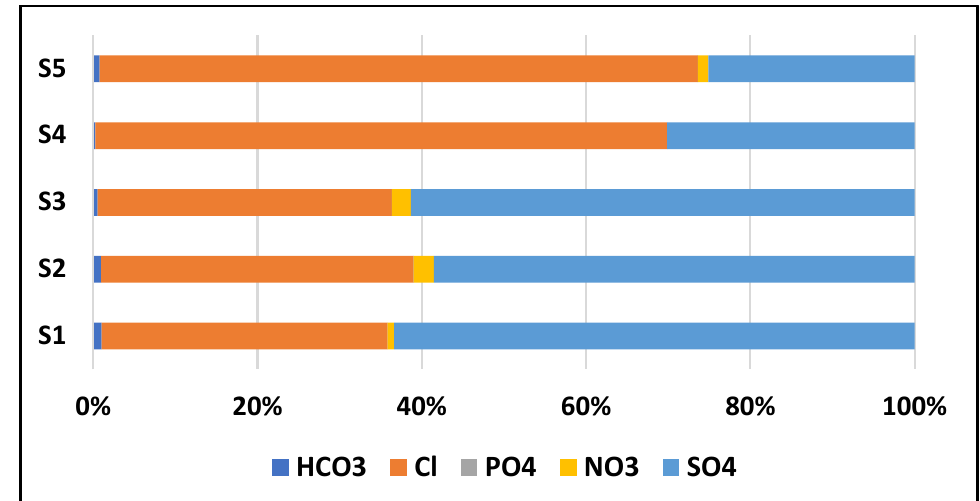
Figure 3. The abundance of the major anions for all sites.